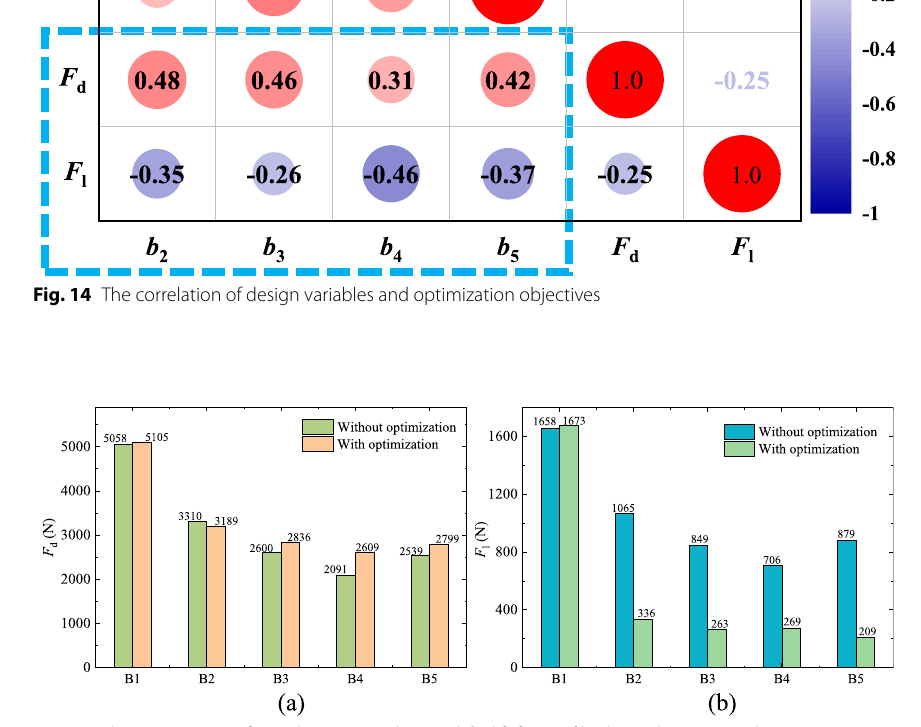
Fig. 15 The comparison of aerodynamic ( a ) drag and ( b ) lift force of braking plates pre and post